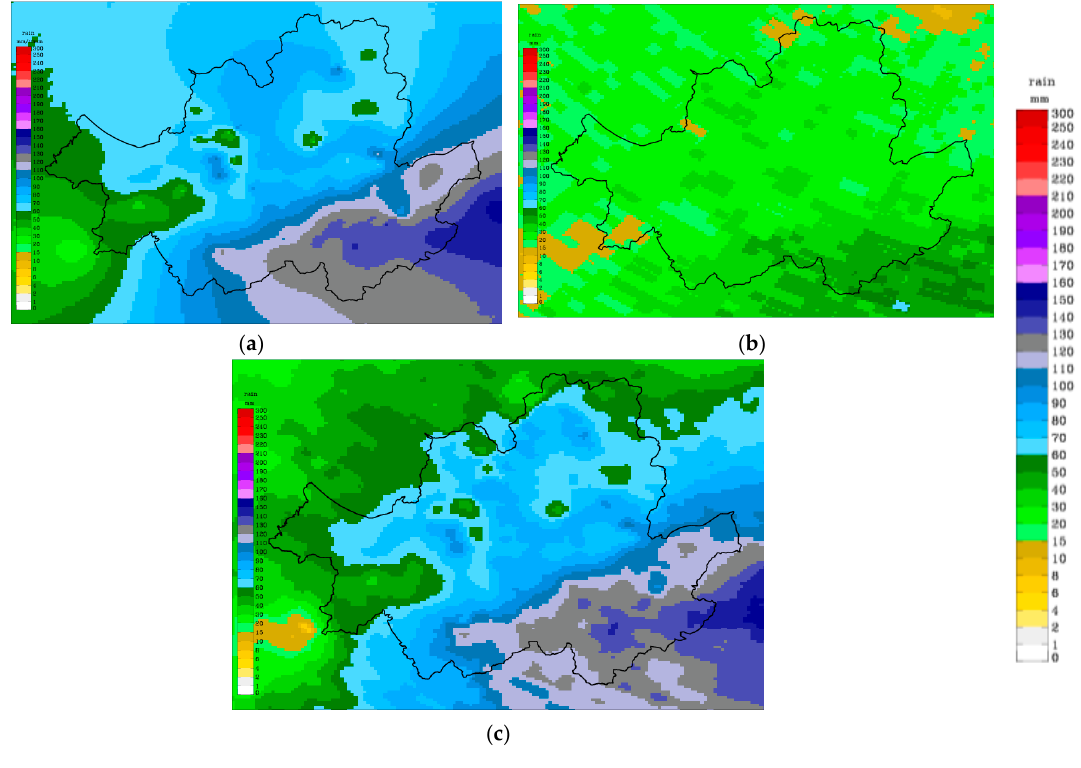
Figure 2. Accumulated rainfall distribution determined on 22 July 2013 using quantitative precipitation estimation methods: ( a ) QPE 1; ( b ) QPE 2; ( c ) QPE 3.